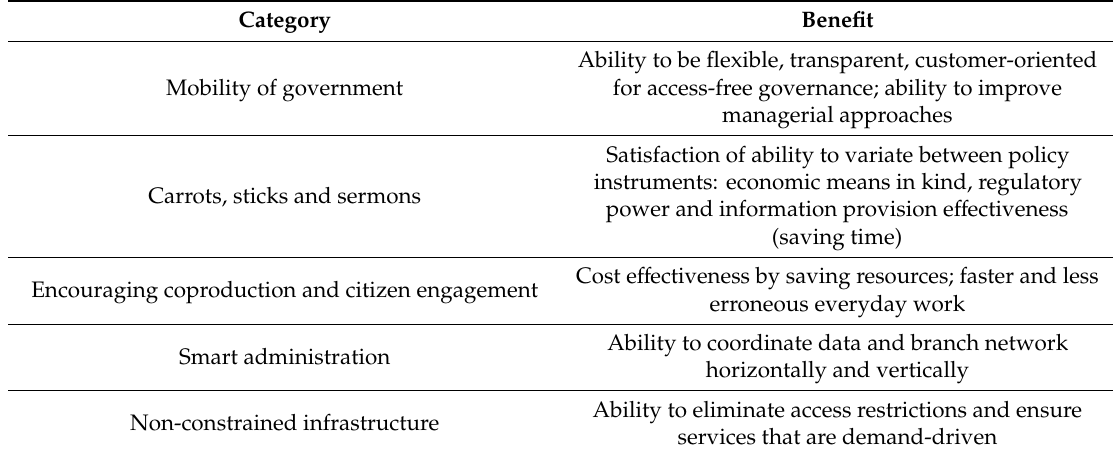
Table 1. Benefit of MGov for the